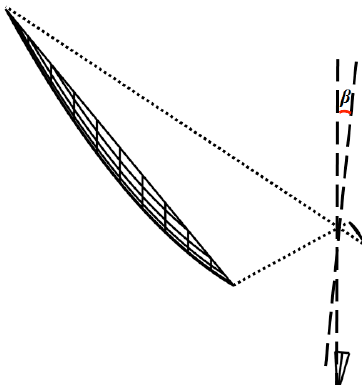
Figure 4: Optical arrangement of an offset Gregorian antenna.